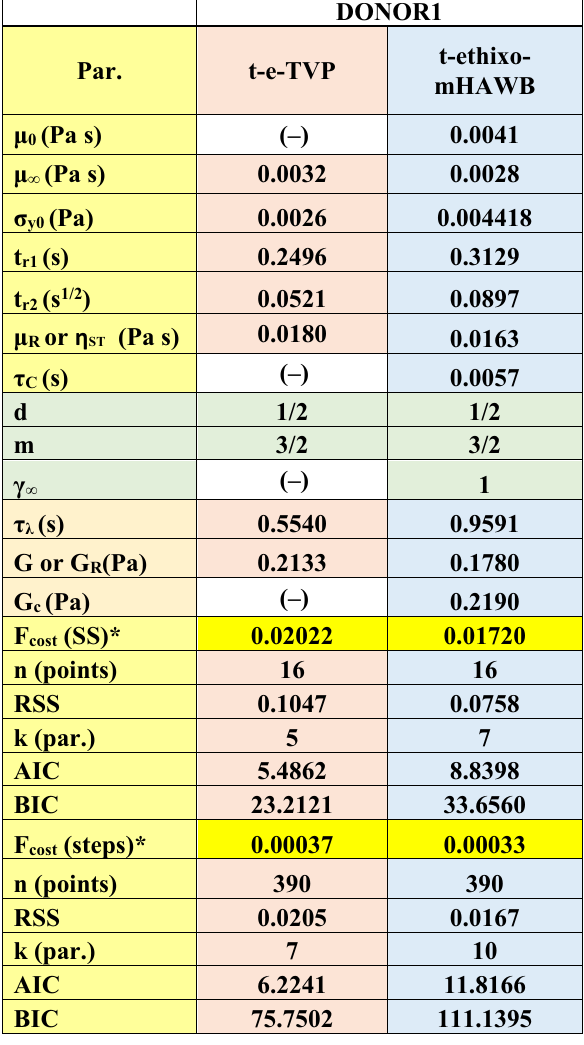
Table 5. Best fit model parameters, and F cost of fits for Donor 1 with t-e-TVP and t-ethixo-mHAWB models. Highlight legend: yellow–steady state fit; green—fixed; orange (salmon column) t-e-TVP step up/down fits; orange (blue column)—t-ethixo-mHAWB step up/down fits. (Donor 1, Dataset 1) 49